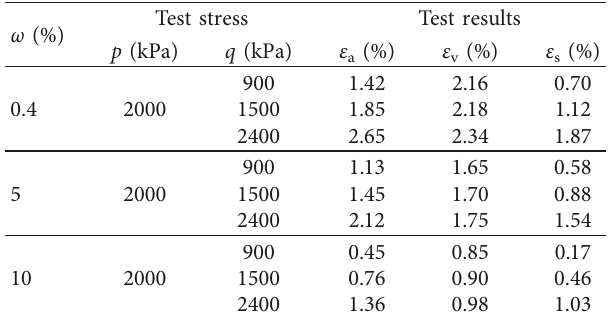
Table 4: Test stress conditions and test results (different initial water